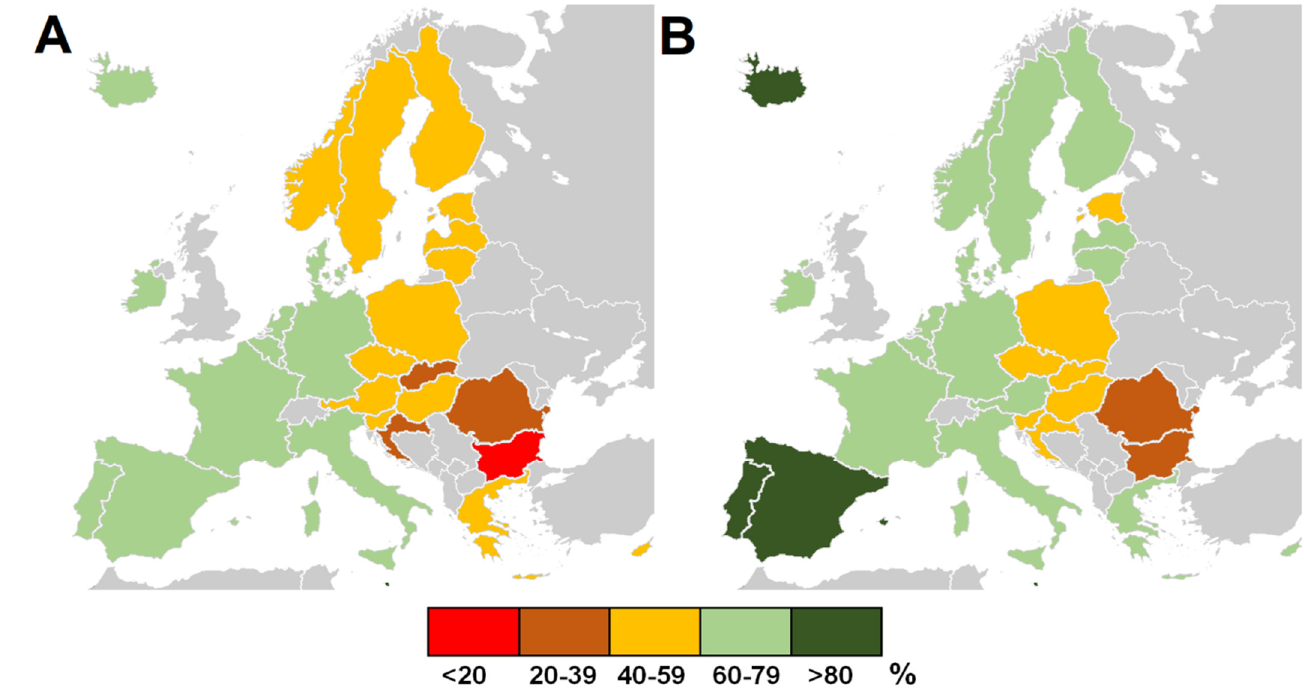
Figure 1. The share of fully vaccinated individuals in different EEA countries at the beginning of ( A ) September 2021 and( B ) December 2021. Based on [19]. ( A ) September 2021 and ( B ) December 2021. Based on